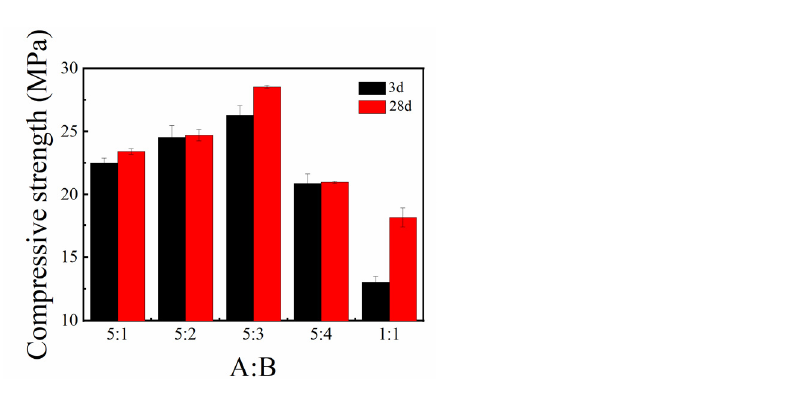
Figure 8. Effect of the ratio of A to B on the flexural strengths of the cement stone at the ages of 3 d and 28 d.